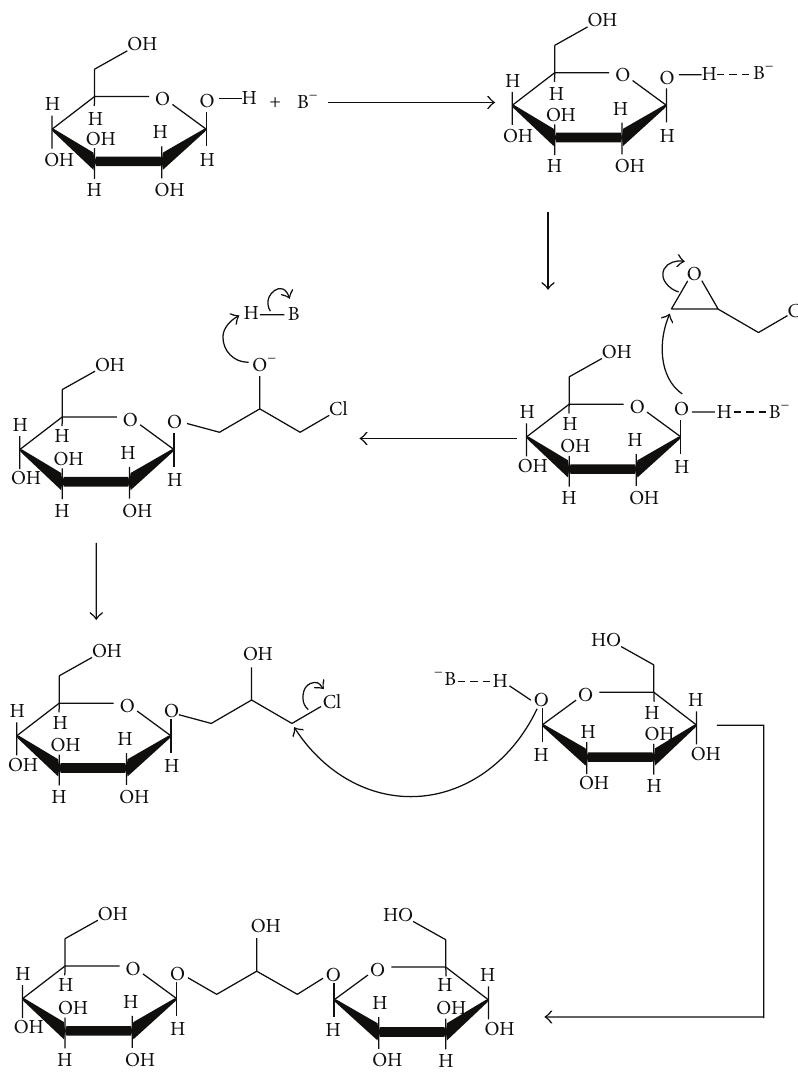
Figure 2: The reaction process of glucose and epichlorohydrin.